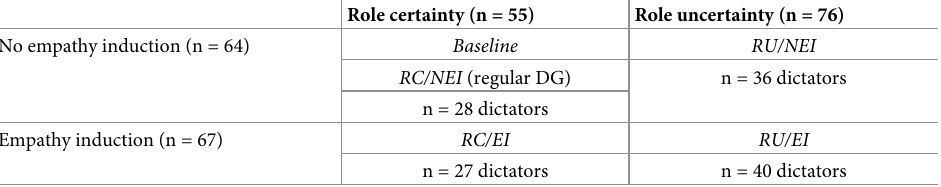
Table 1. Experimental